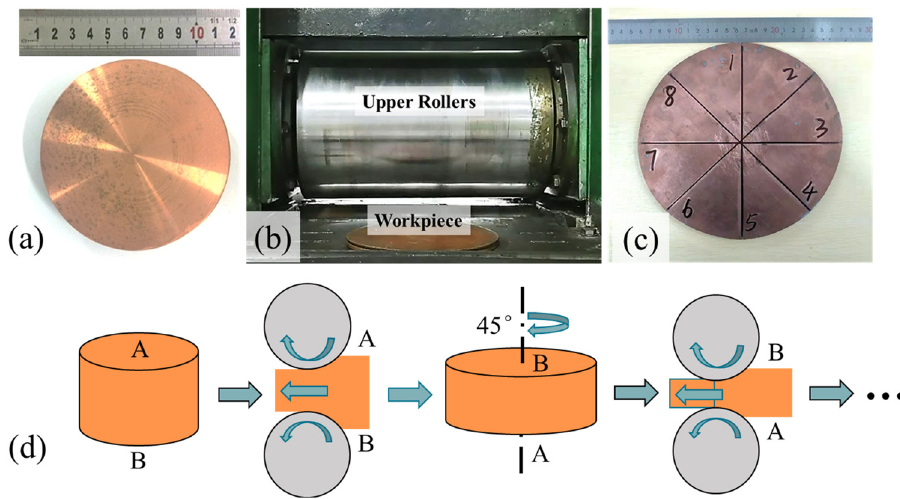
Figure 2: Multi - pass rolling experiment: ( a ) initial plate of the pure copper, ( b ) double - roll synchronous mill, ( c ) rolled part, and ( d ) schematic of the 15 - pass rolling